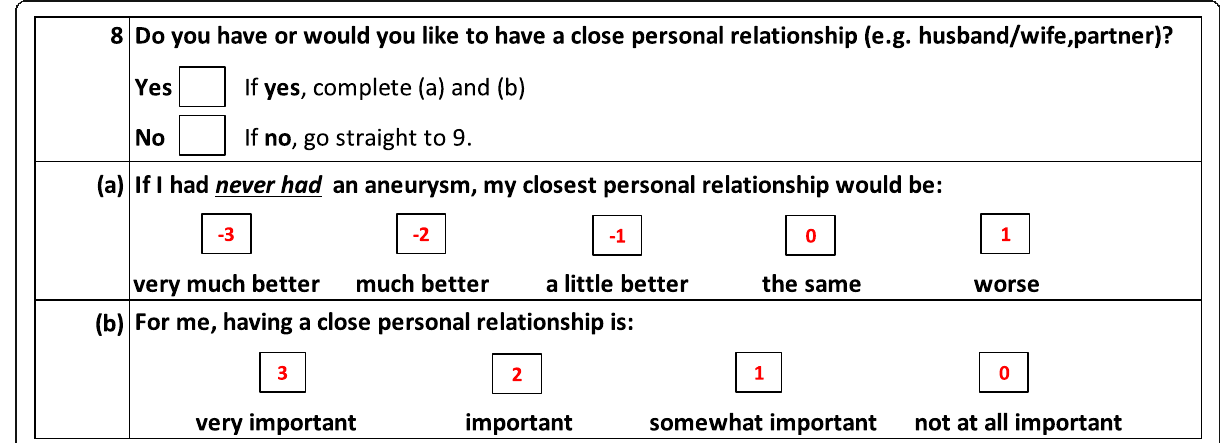
Fig. 1 Example item from the AneurysmDQoL (numbers indicate score assigned to each